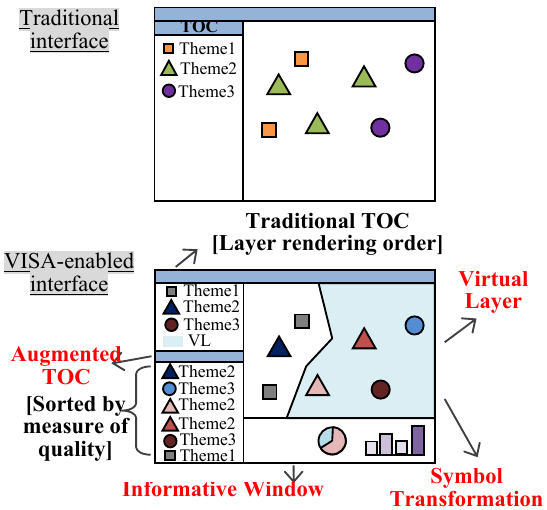
Figure 2. Comparison of traditional GIS interfaces and VISA-enabled interface